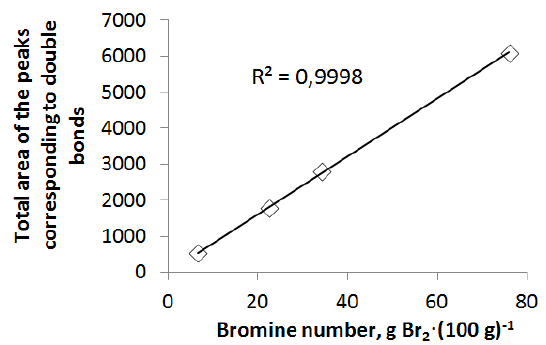
Figure 10. Correlation between bromine number and total area of 1 H-NMR peaks corresponding to hydrogen atoms at double